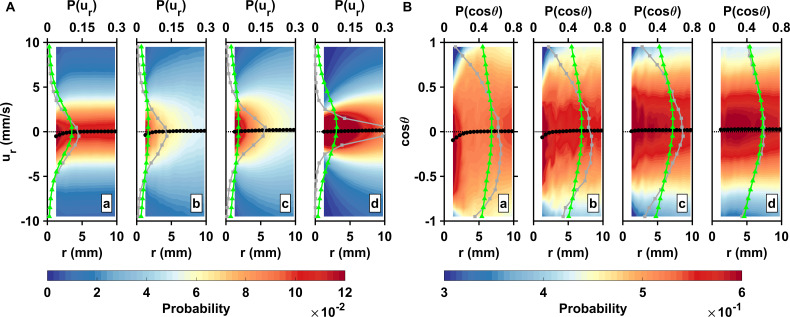
Inward motion within the perception distance converts high encounter rates brought by active motion into actual contact events.(A) Probability density functions of the pairwise radial relative velocity ur versus the separation distance r for living copepods in calm water (a), living copepods in turbulence (b), inert carcasses in turbulence (c), and tracers in turbulence (d). The pairwise separation distance is along the horizontal axis, the velocity is along the vertical axis, and the probability is given by the color intensity. As an illustration for the shift in the distribution, the gray (squares) and green (triangles) curves show P⁢(ur) at r=1 mm and r=10 mm, respectively. The black curve (circles) indicates the mean value at each bin of r. ur is negative when two particles move toward each other. ⟨ur⟩ is negative at small r, indicating a net flux of organisms into the perception volume. (B) Probability density functions of the cosine of the approach angle θ versus the pairwise separation distance r, and mean values. θ is defined as the angle between the relative velocity vector and the particle separation vector. Negative values of cos⁡(θ) indicate that the two particles of the pair move inward toward each other. Note that the color scale has been truncated for better visibility. The gray and green curves show P⁢(c⁢o⁢s⁢θ) at r=1 mm and r=10 mm, respectively.Figure 3—source data 1.Source data for Figure 3.